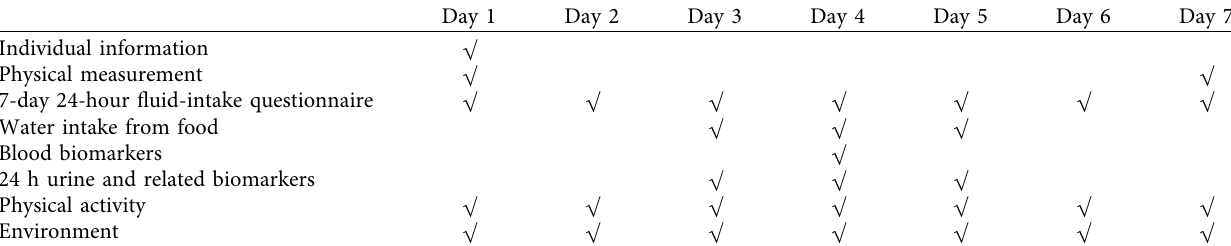
Table 2: The indicators were collected at different time points in the